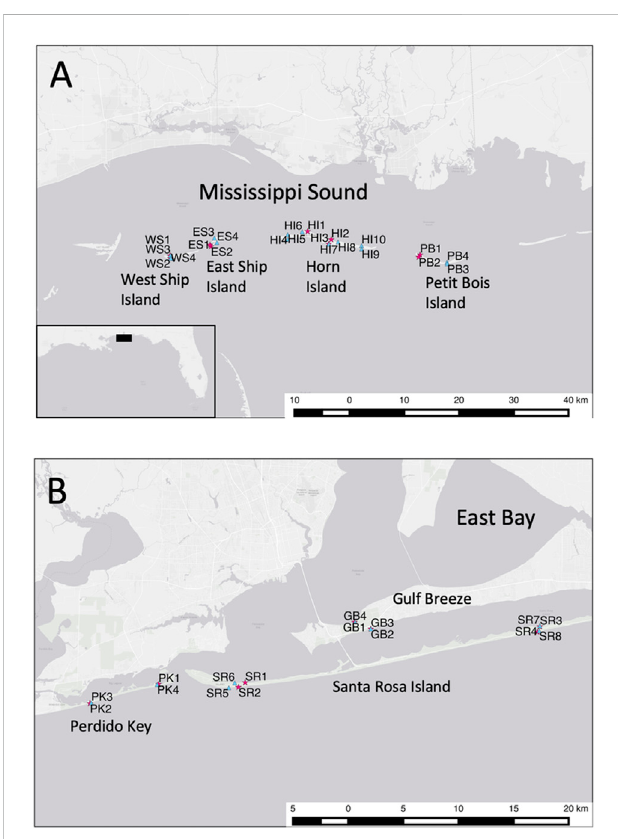
FIGURE 1 (A) Map of western district of the Gulf Islands National Seashore (GINS) study area, showing sites sampled for the 1993 macrofaunal inventory (red stars) and the 2010 macrofaunal pre-oil DwH survey (blue triangles); (B) . Map of eastern district of the GINS study area, showingsitessampledforthe1993macrofaunalinventory(redstars)and the 2010 macrofaunal pre-oil DwH survey (blue